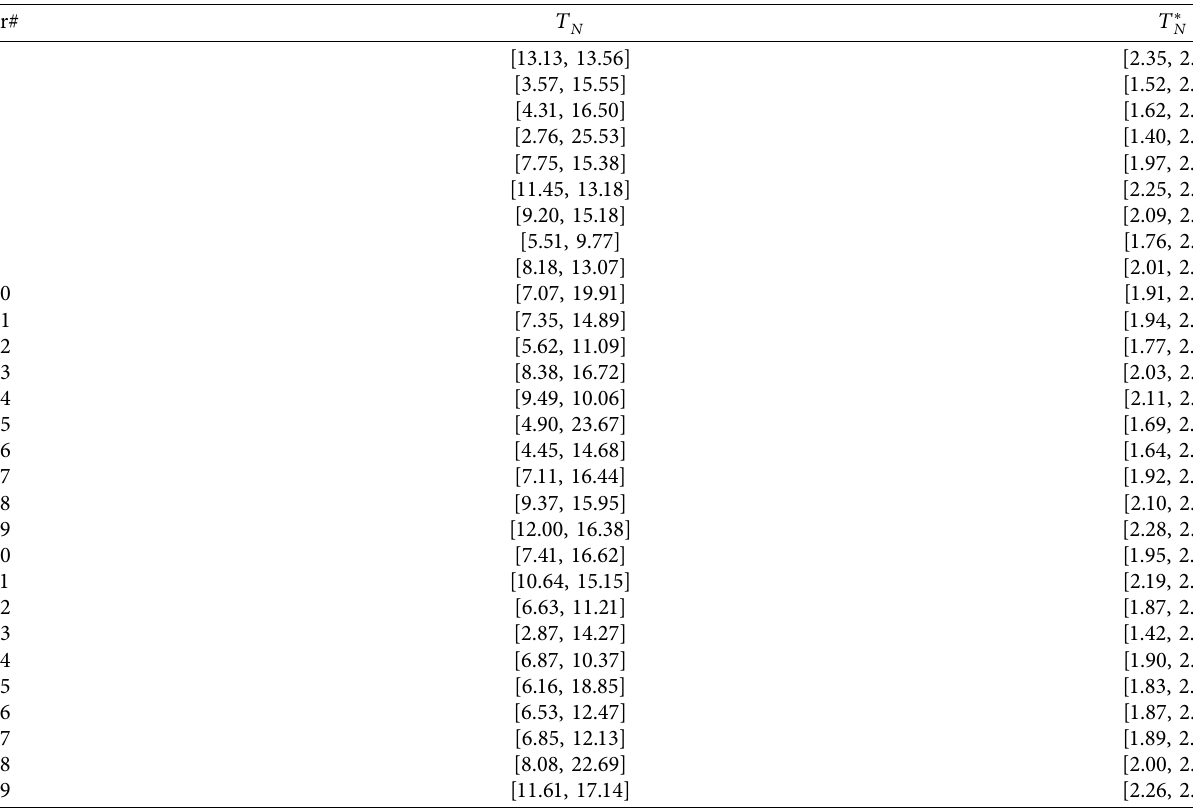
Table 4: The neutrosophic UTIs’